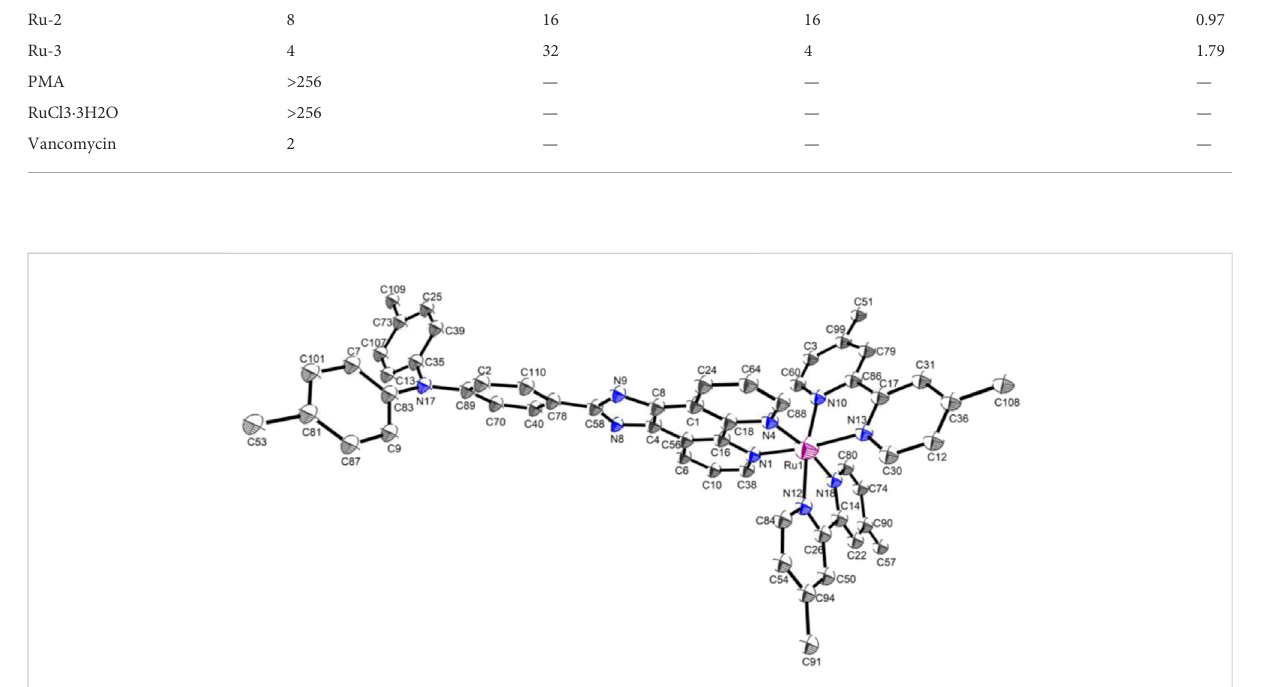
FIGURE 2 Thermal ellipsoid plot of Ru-3 in ORTEP view.